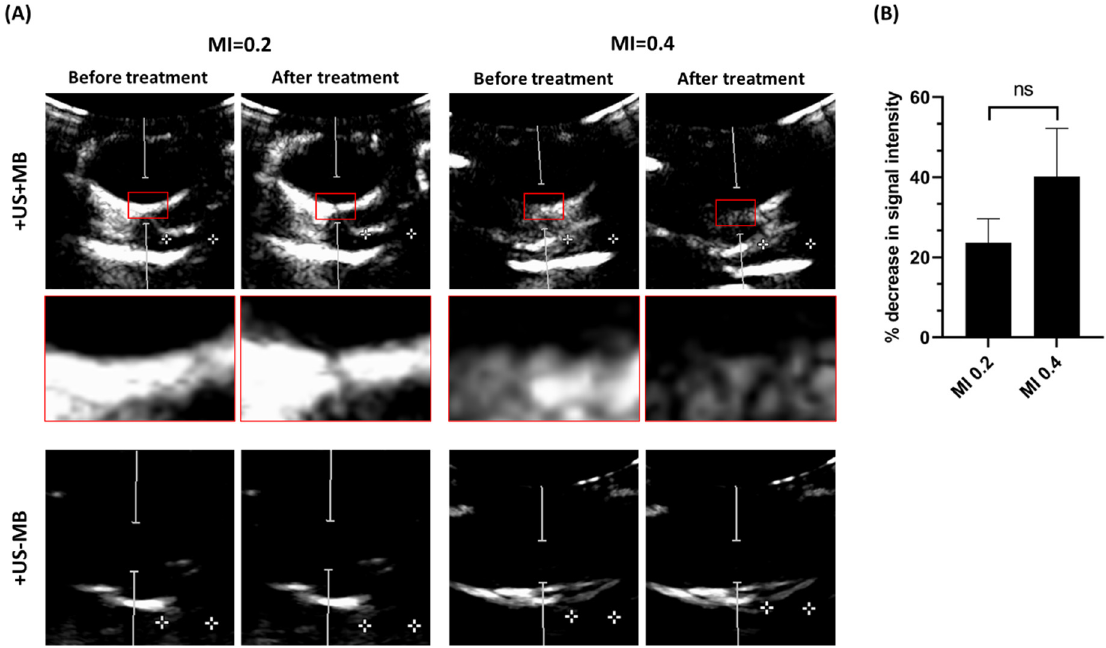
Figure 4. ( A ) Ultrasound contrast images from porcine eyes treated with UMSB (+US+MB) or ultrasound only (+US − MB) at MI 0.2 and 0.4. Red boxes indicate enlargement of the focal area of the probe. Contrast signal was minimally (MI 0.2) and strongly (MI 0.4) decreased after USMB treatment. Distance between the two crosses is 1 cm. ( B ) Percentage of decrease in signal intensity of microbubbles within the PW Doppler cursor area after treatment with USMB at MI 0.2 and 0.4 (n = 4), ns: not significant.